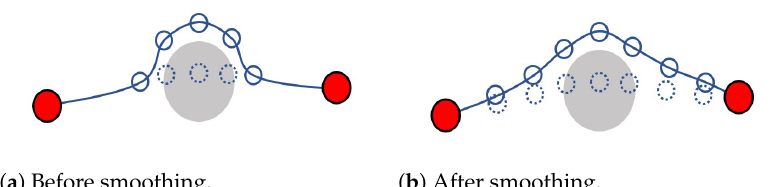
Figure 4. Smoothing